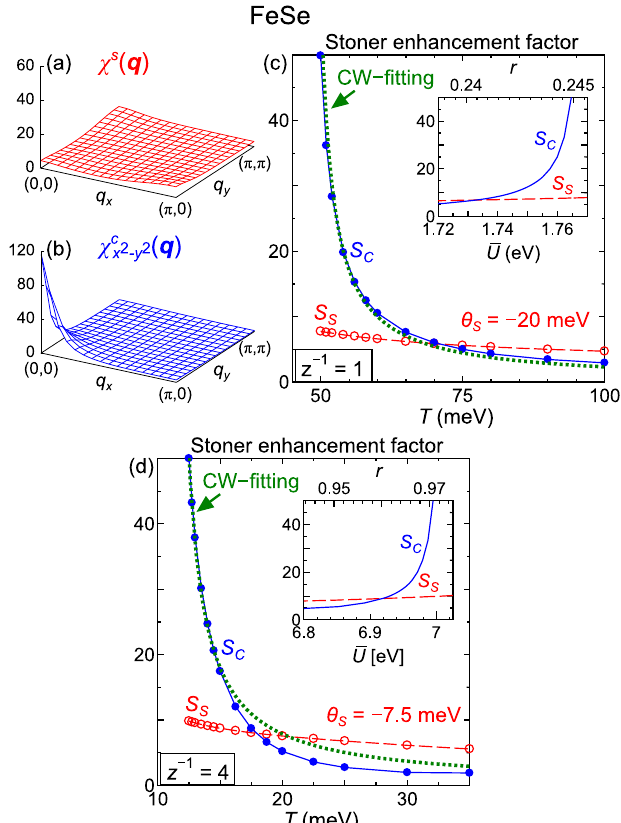
FIG. 3. (a) χ s ð q Þ and (b) χ c ð q Þ obtained by the SC-VC x 2 − y 2 method for FeSe ( z ¼ 1 ), for r ¼ 0 . 25 at T ¼ 50 meV. (c) T dependence of the Stoner enhancement factors for FeSe ( z ¼ 1 ) ¯ U at r ¼ 0 . 25 . Note that ¼ 7 . 21 r eV for FeSe. Inset: Stoner enhancement factors as a function of r for FeSe ( z ¼ 1 ) at T ¼ 50 meV. (d) T dependence of the enhancement factors for FeSe ( z − 1 ¼ 4 ) at r ¼ 0 . 97 . The charge and spin Weiss temper- 12 meV and θ ∼ − 7 . 5 meV, respectively. atures are θ C ¼ S Inset: Stoner enhancement factors as a function of r for FeSe ( z − 1 ¼ 4 ) at T ¼ 12 . 5